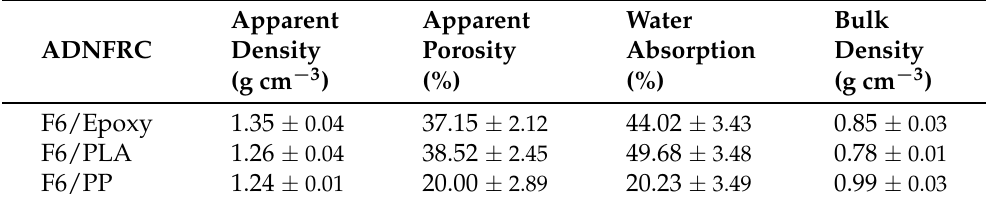
Table 3. Physical properties of 6 mm flax-ft aligned discontinuous natural fibre reinforced composites (F6). Errors represent SD.